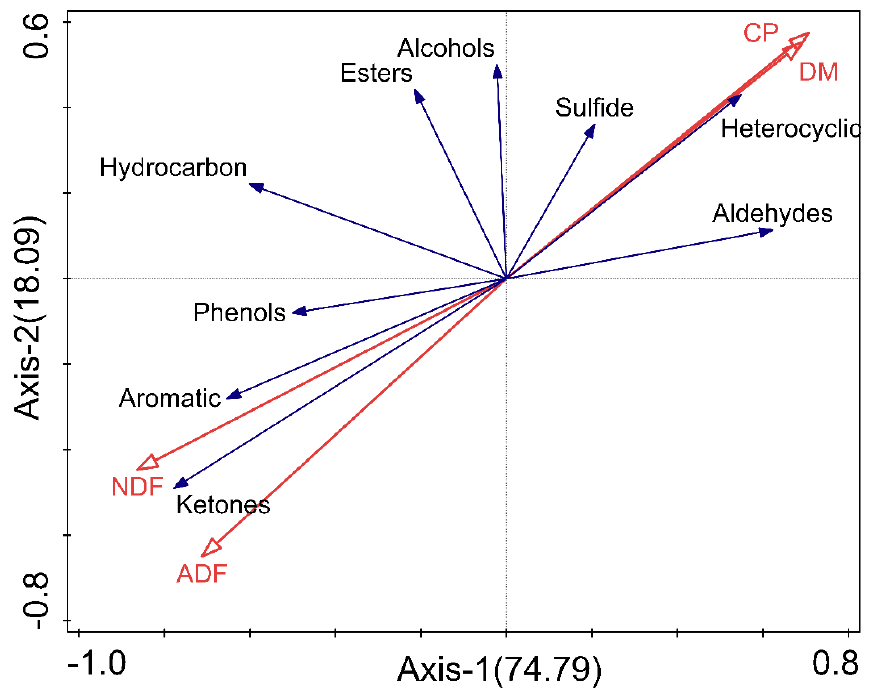
Figure 9. Redundancy analysis of alfalfa nutrition and VOCs. The cosine value between nutrition and VOCs represents the correlation between them. A positive cosine value indicates a positive correlation, and a negative value represents a negative correlation. The red arrow represents the nutritional indicators of alfalfa, purple arrows indicate alfalfa VOCs. The length of the line indicates the magnitude of the contribution of the nutrient to explaining the formation of VOCs.